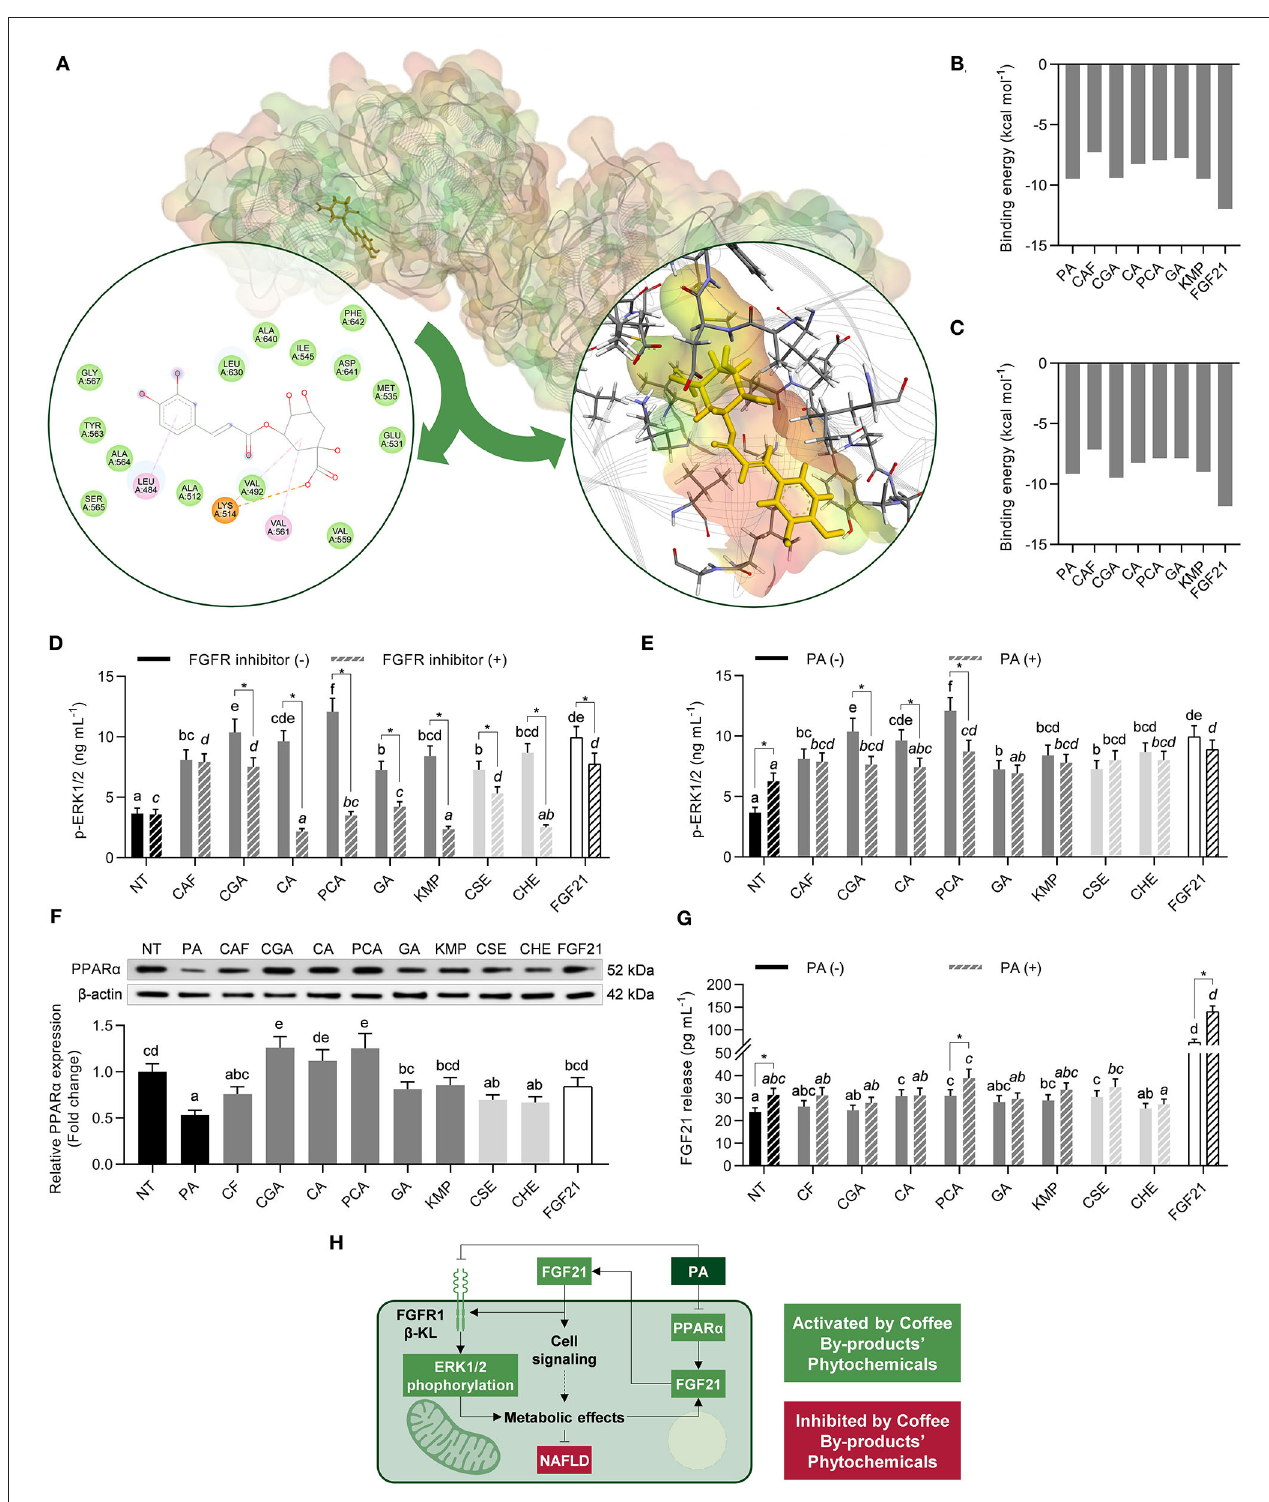
FIGURE 2 | Activating effects of standard solutions of the bioactive compounds from coffee by-products (50 µ mol L − 1 ), aqueous extracts (CSE and CHE, 100 µ g mL − 1 ), and FGF21 (20 nmol L − 1 ), in the presence of PD173074 (FGFR1 inhibitor, 50 nmol L − 1 ) or palmitic acid (PA, 500 µ mol L − 1 ), on FGF21 signaling in HepG2 human hepatocytes. Coffee by-product’s bioactive compounds interacted in silico with the subunits of the FGF21 receptor (FGFR) (A) , exhibiting different binding